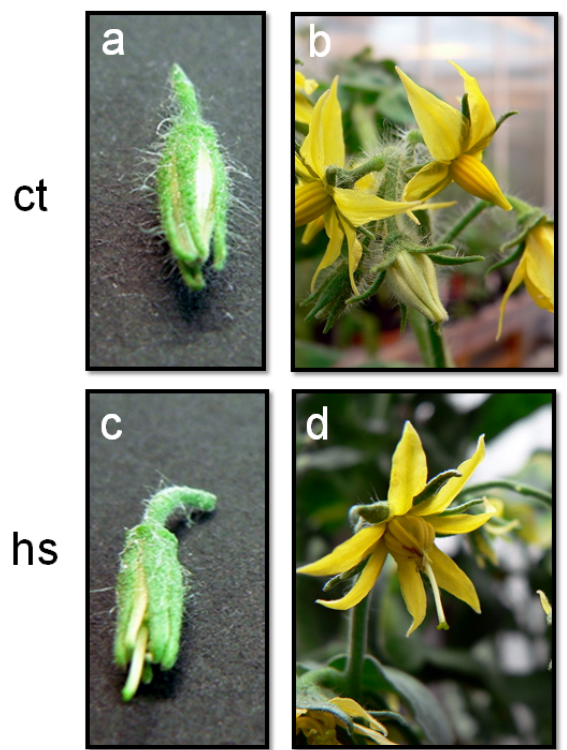
Figure 2. Phenotypic alterations in tomato flowers exposed to prolonged heat stress (hs) conditions. ( A , B ) Young flower buds of 8 mm in length and flowers at anthesis stage harvested from tomato plants (cv Saladette) grown under normal temperature (ct: 26 °C/19 °C; day/night). ( C , D ) Flower buds and opened flowers from plants exposed to prolonged high temperature conditions (hs: 36 °C/26 °C; day/night). Abnormal anthers and style elongation are observed in flowers treated with